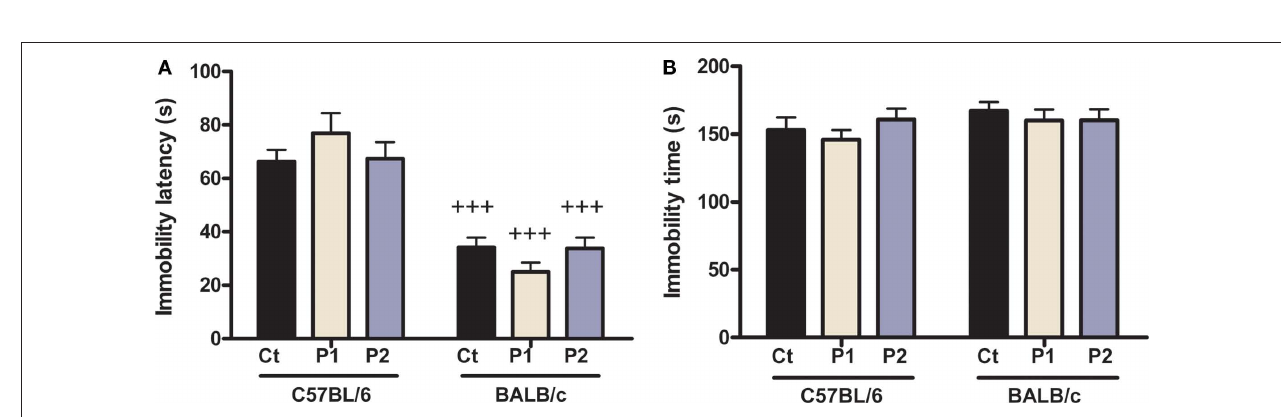
to immobility than BALB/c mice. n = 11–19 per strain per stress condition. Data expressed as means ± SEM. Black “Ct,” control AFR groups; white